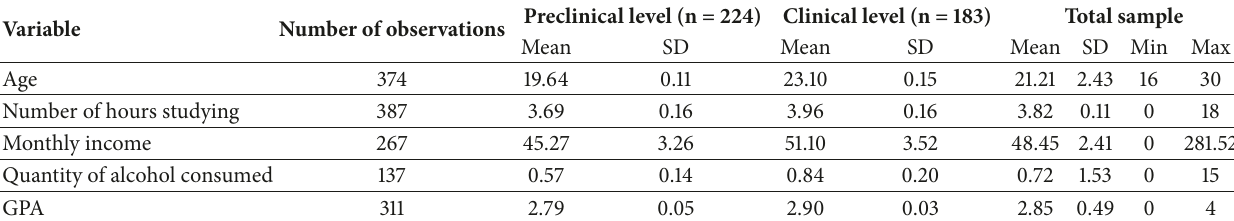
Table 2: Continuous variables showing the sociodemographic characteristics of 413 medical students in Cameroon assessed for burnout syndrome from January to March